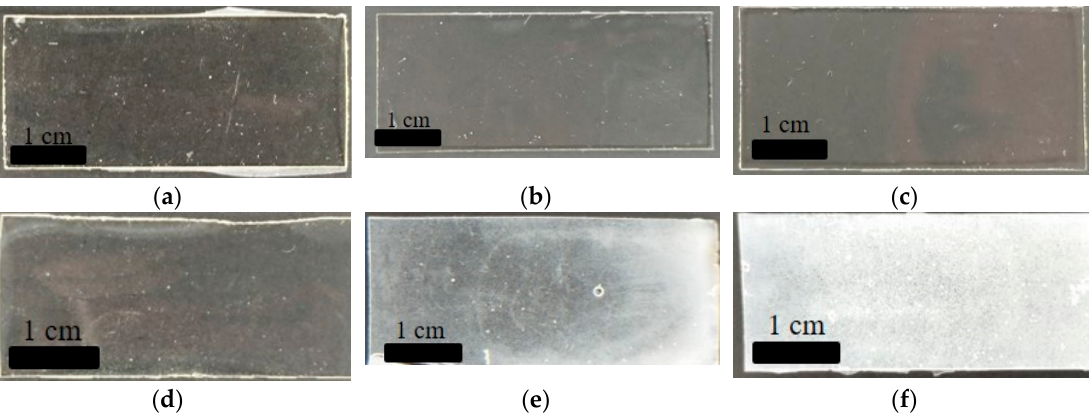
Figure 1. Visual observation of PGSA30-co-PEGDA in ( a ) 2:1, ( b ) 1:1, ( c ) 1:2 ratio, and PGSA30- co -PCLDA in ( d ) 2:1, ( e ) 1:1, ( f ) 1:2 ratio. in ( d ) 2:1, ( e ) 1:1, ( f ) 1:2